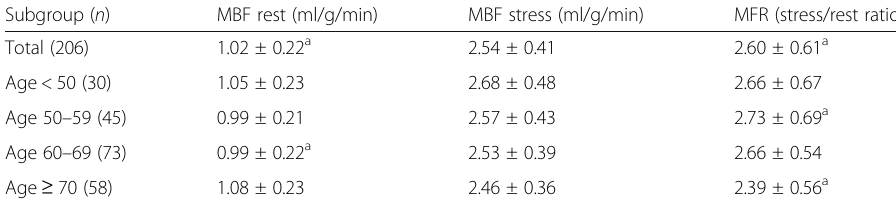
Mean results ± standard deviation MBF Myocardial Blood Flow, MFR Myocardial Flow Reserve a not normally distributed by Shapiro-Wilk